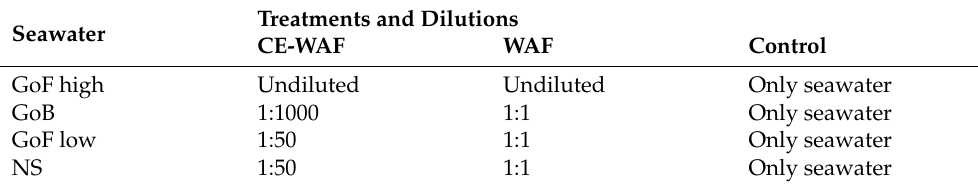
Table 2. Overview of samples and dilutions used in different microcosm